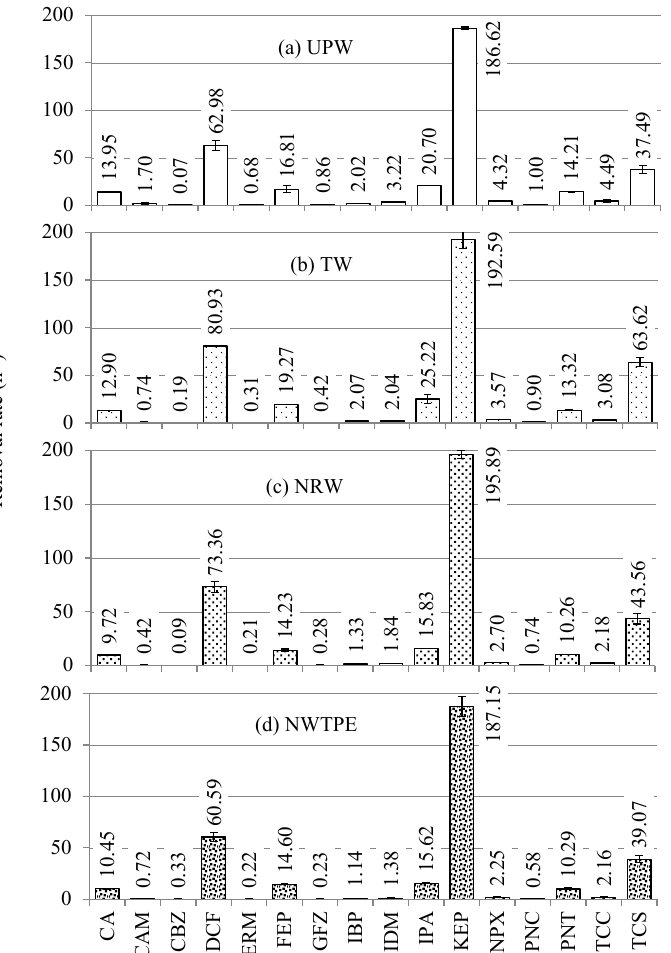
Figure 3. Pseudo first-order removal rates for PhCs (n = 3, 30 min reaction) by UVC photolysis in simulated mixed solutions using ultrapure water (UPW), tap water (TW), Neya River water (NRW) and Nakahama wastewater treatment plant effluent